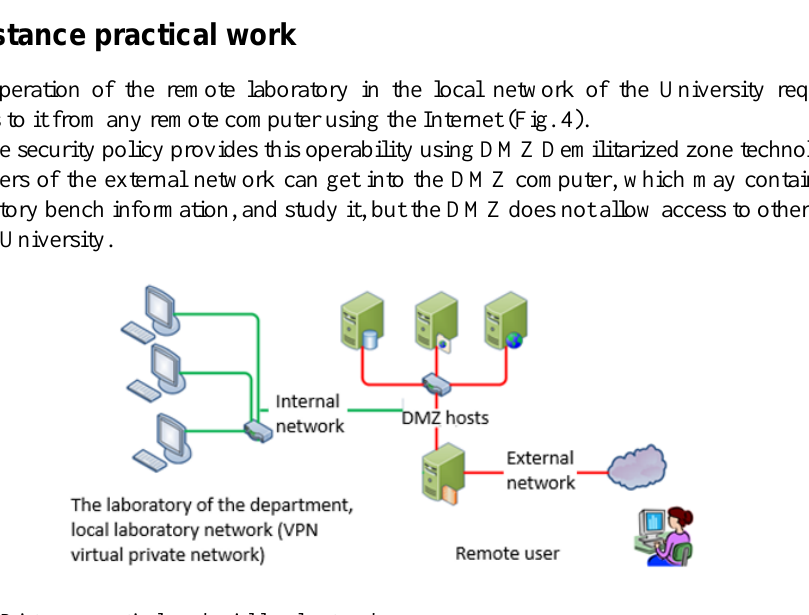
Fig. 4. Distance practical work vial local